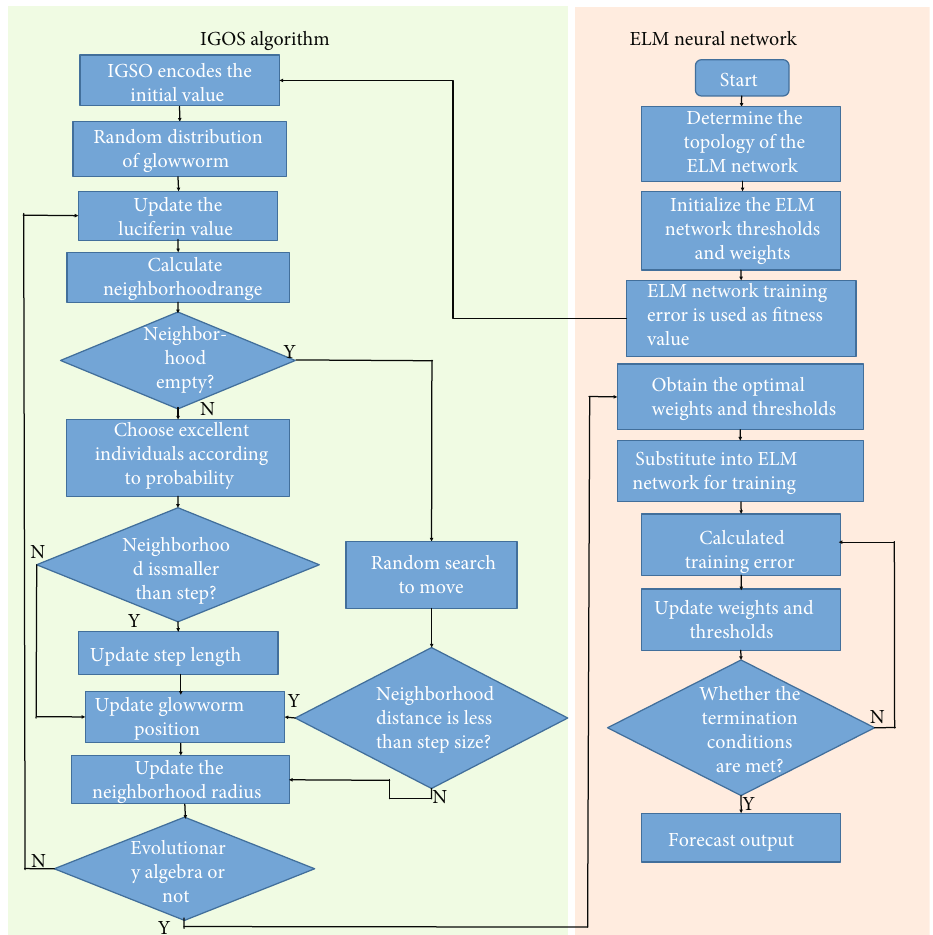
Figure 4: The optimization process of ELM neural network by IGSO